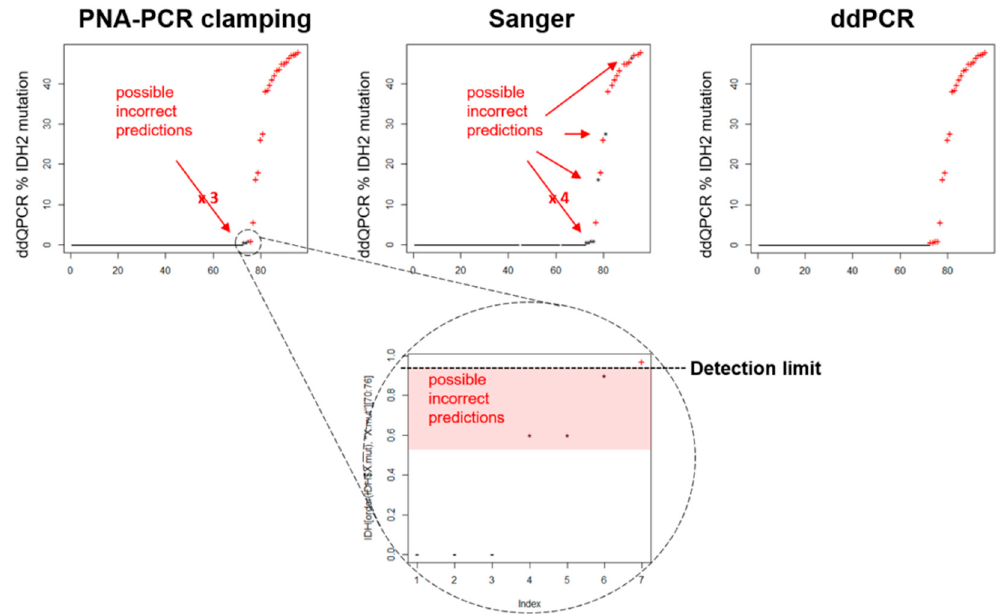
Figure 5. IDH2 status evaluation techniques detection limits and results agreement. The graphs indicate all the variant allelic frequency (VAF) of IDH2 mutations identified in AML patients with ddPCR and sorted from 0% (WT) to 50% mutated (heterozygous). ddPCR identified IDH2 mutant already by 0.6% of VAF, while PNA-PCR clamping failed to identify positive patients under the 1% of VAF (zoom of this region is showed in the dotted circle). Contrariwise, the discriminatory ability of Sanger sequence was randomly distributed in all ranges of IDH2 mutation percentage, decreasing the robustness of the analysis. Negative ( − ), positive (+) and false negative ( * ).